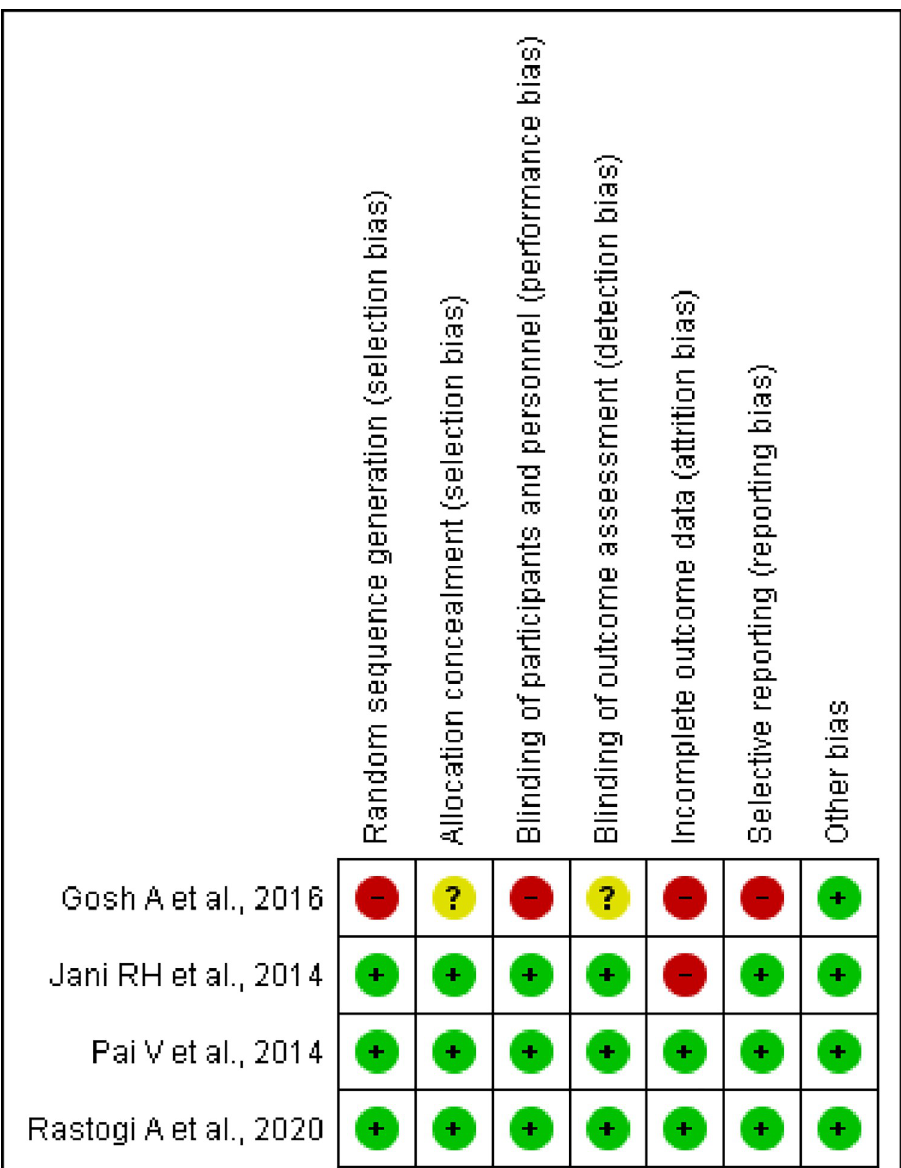
Fig 3. Risk of bias summary. Review author’s judgements about each risk of bias item for each included study.